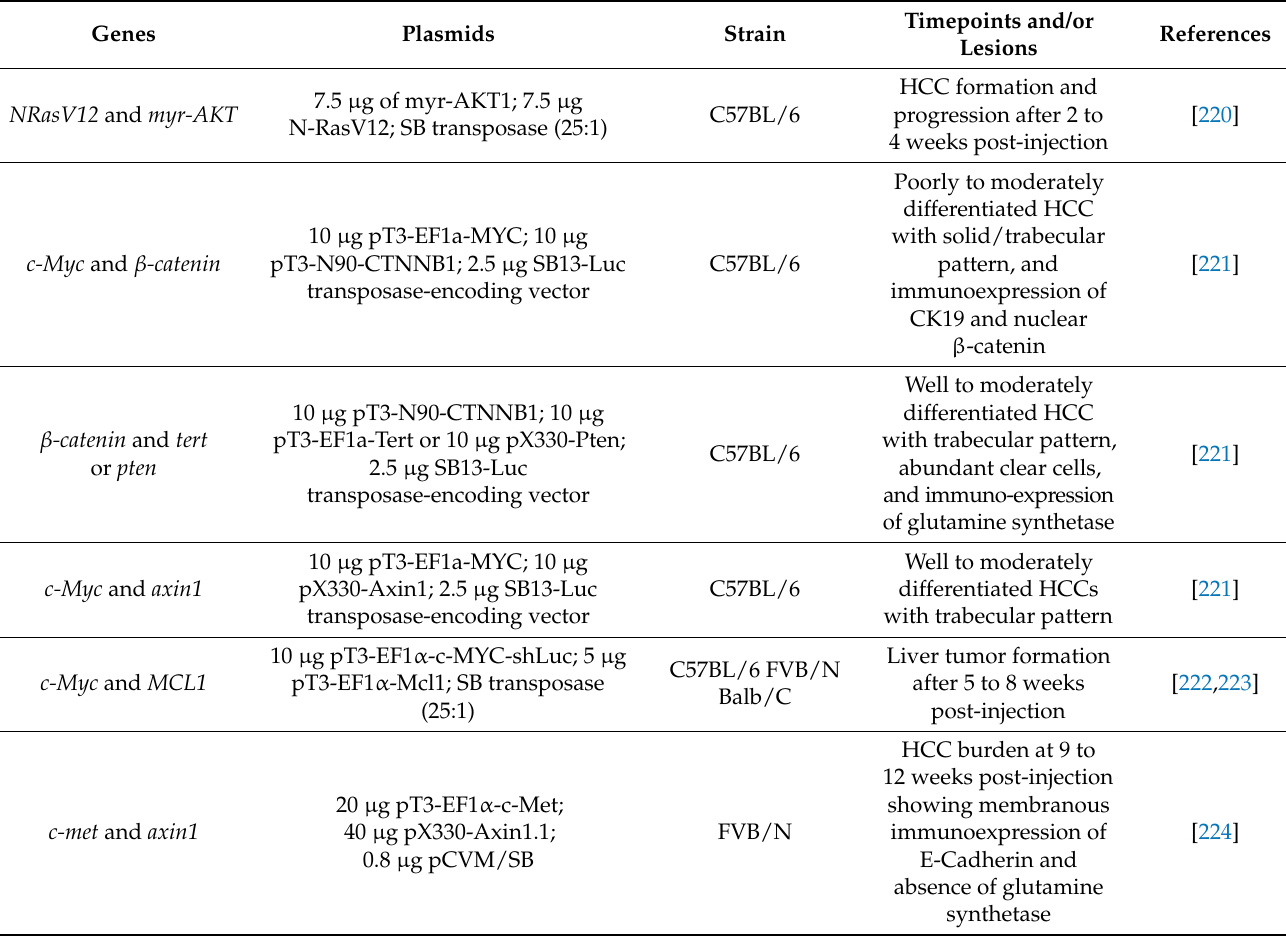
Table 6. Summary of some of the HTV protocols for hepatocarcinogenesis in mice.